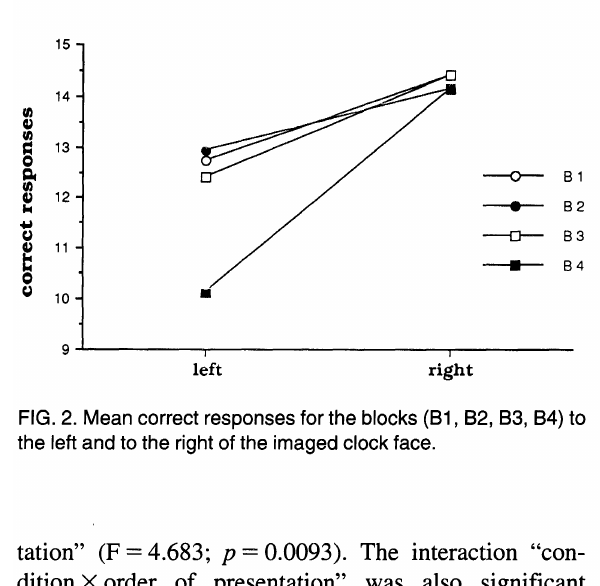
FIG. 2. Mean correct responses for the blocks (81, 82, 83, 84) to the left and to the right of the imaged clock face.